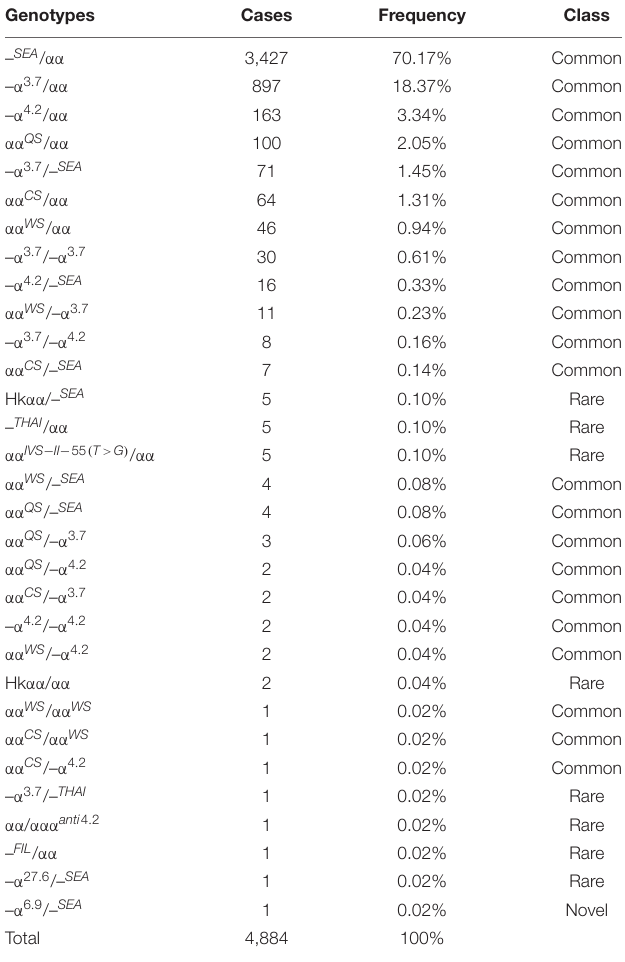
TABLE 1 | Distribution of α -thalassemia genotypes in Quanzhou